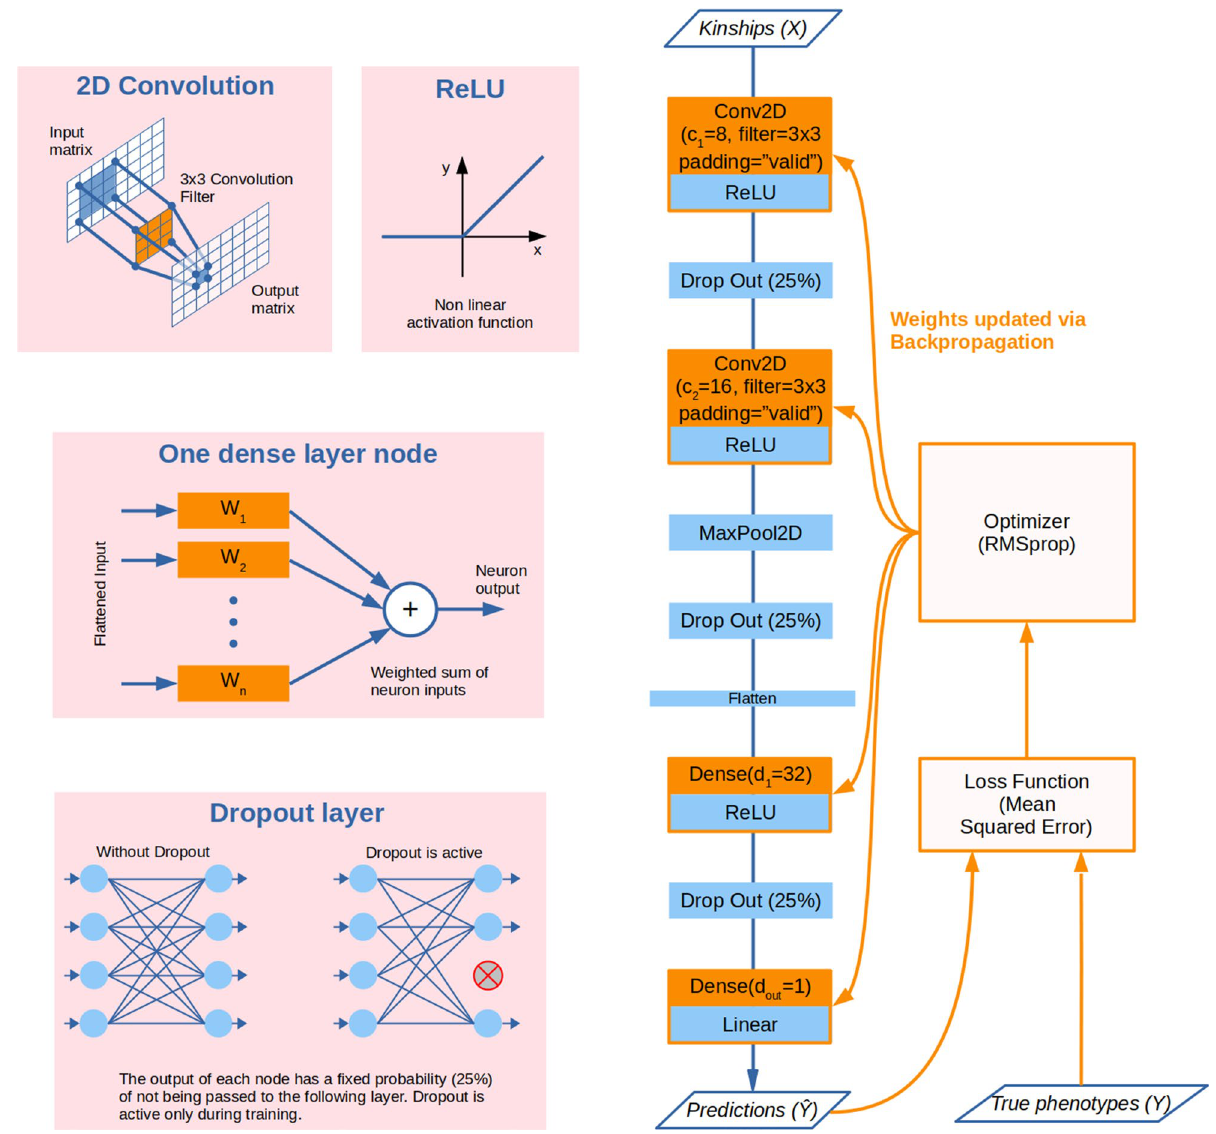
Figure 3. The base deep learning architecture used as a starting point for hyperparameter tuning. The kinships are inputted as a n × n × 15 polyhedron, where n is the number of samples for the training set and 15 is the number of kinship matrices used. Trainable layers are represented in orange. All layers with the exception of the last one use the ReLU activation function. The last layer always has a single node ( d out = 1 ) and uses a linear activation function so to produce a continuous output